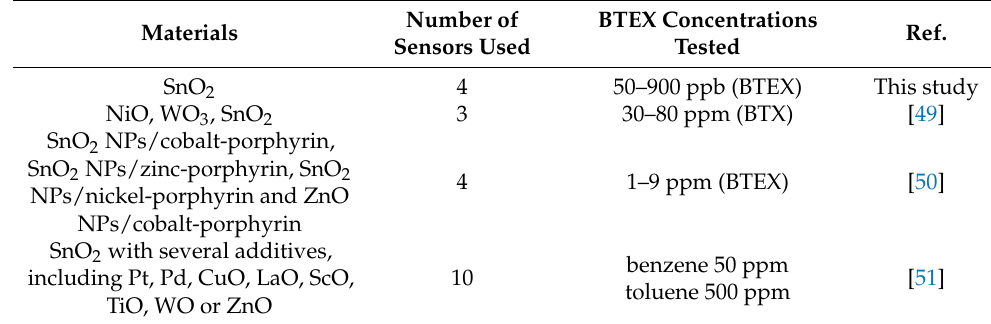
Table 2. A comparison of MOS-based gas sensor arrays for the detection of BTEX in